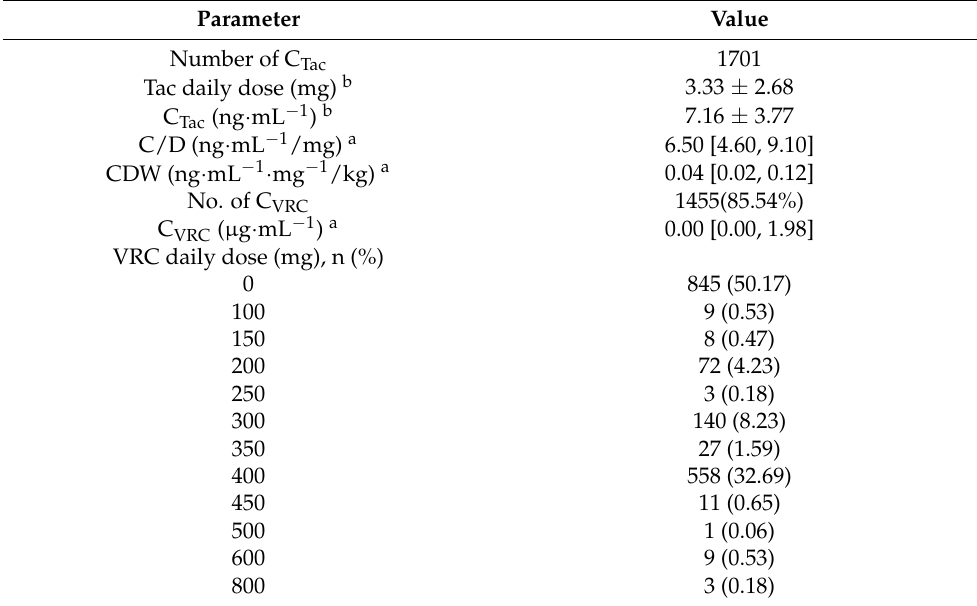
Table 2. Drug use and concentration information of